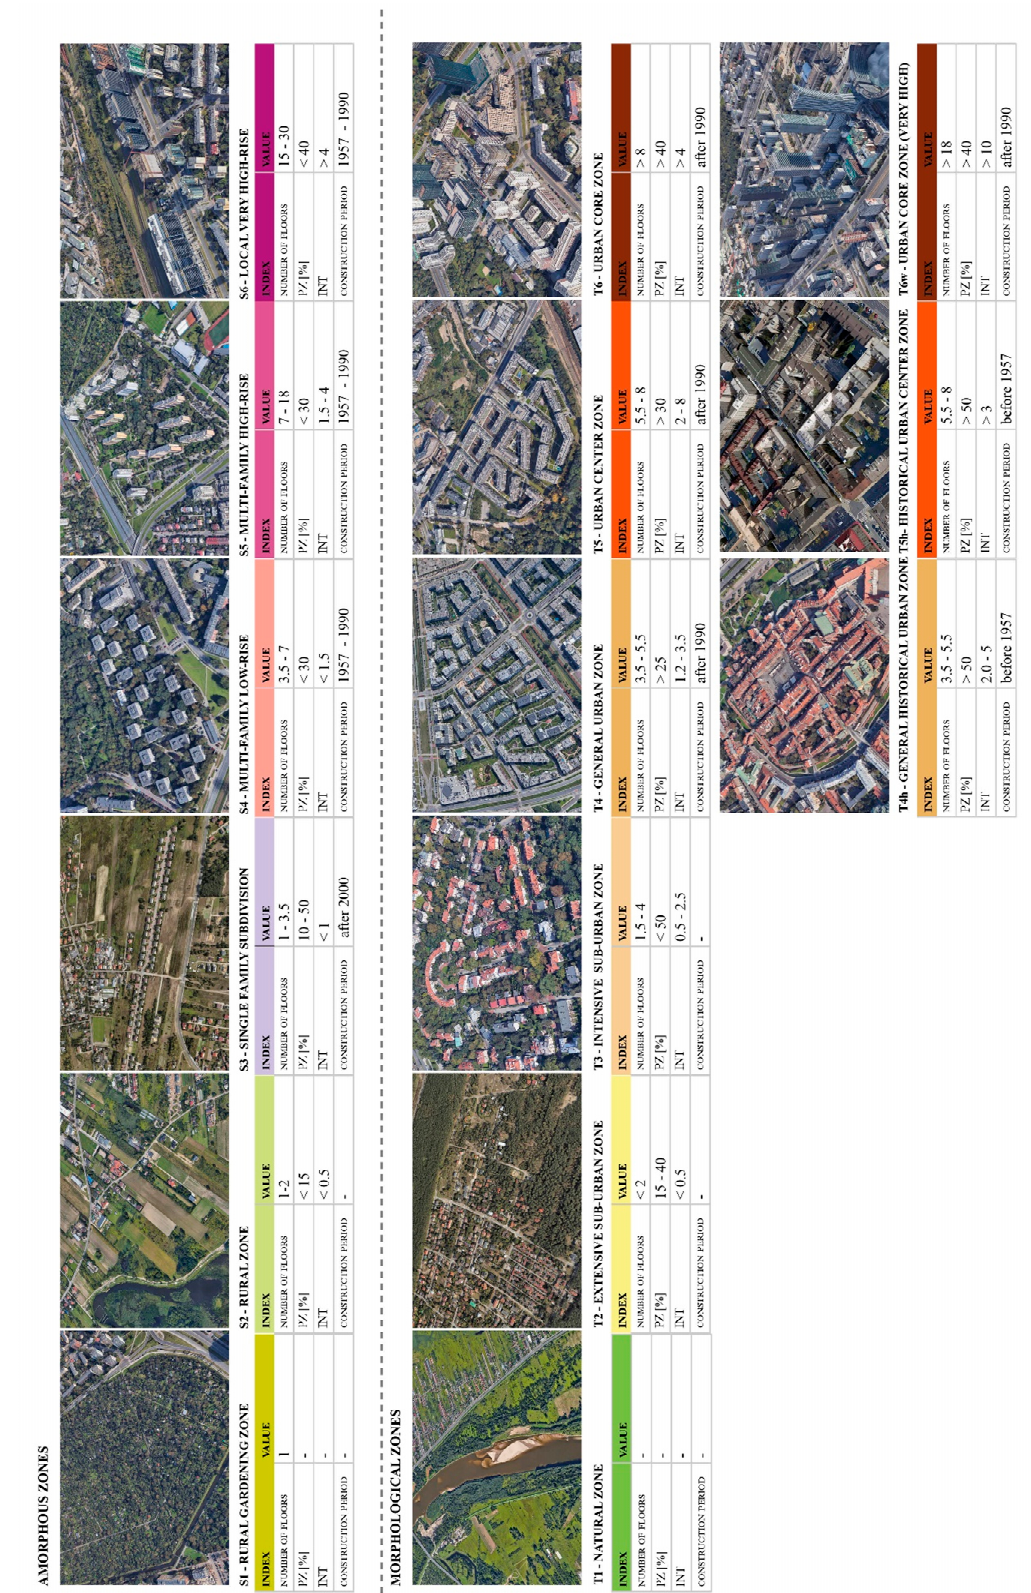
Figure 9. Transect cross-sections for the structure of the city of Warsaw. Source: own study.